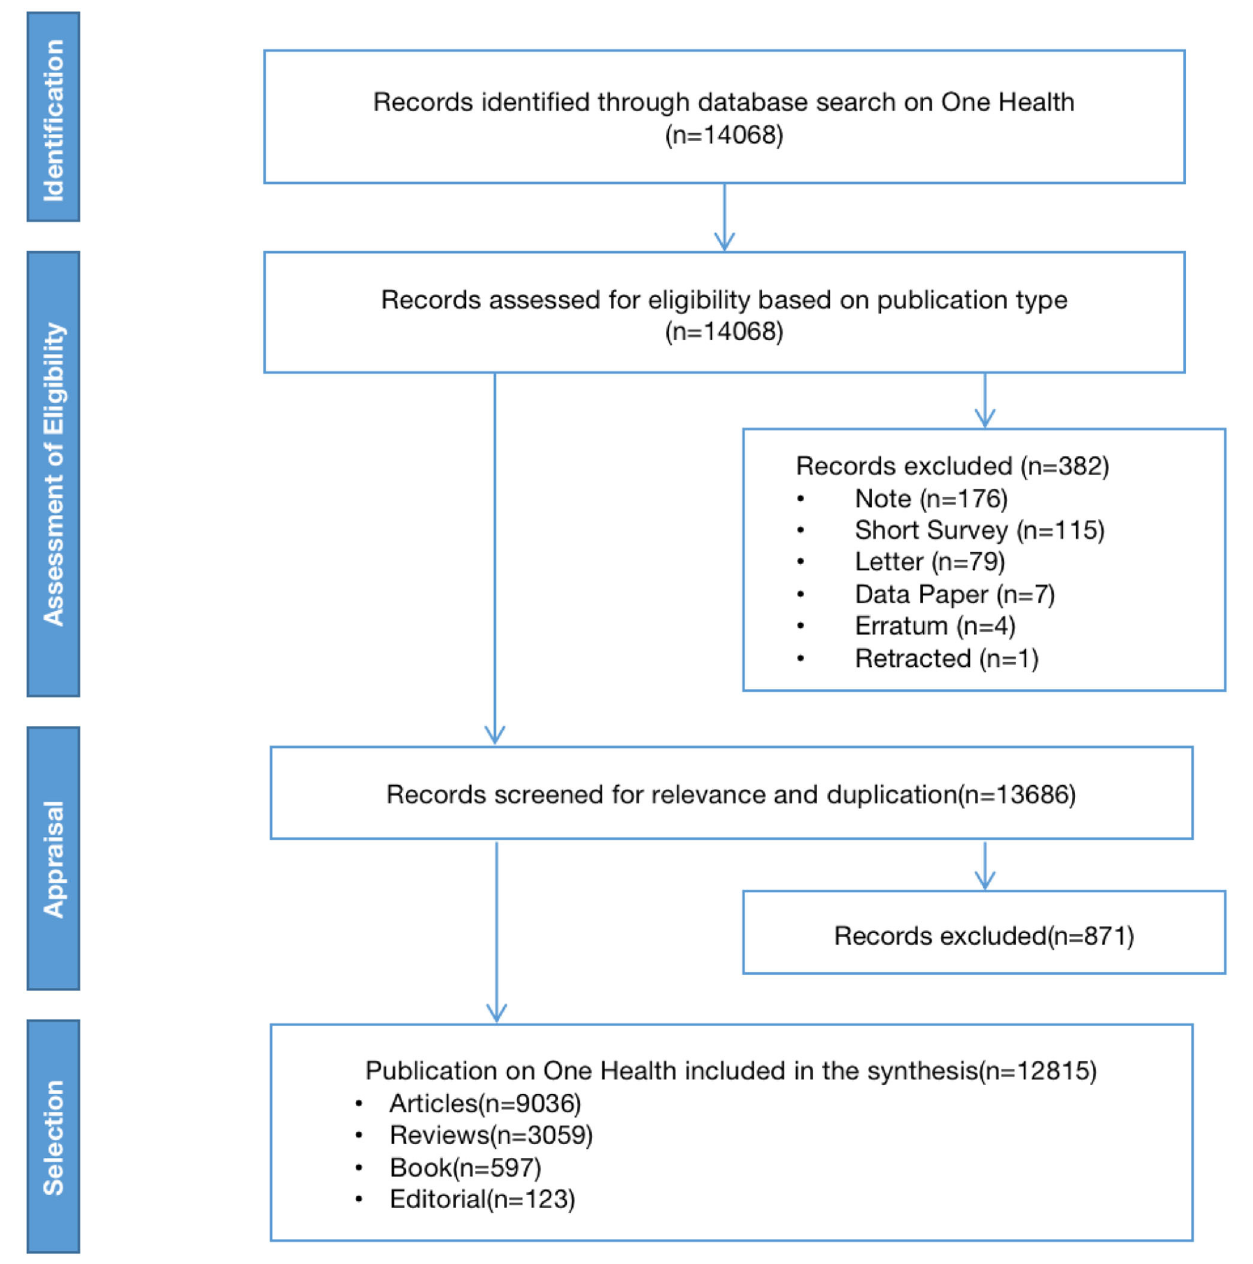
FIGURE 1 | 1PRISMA